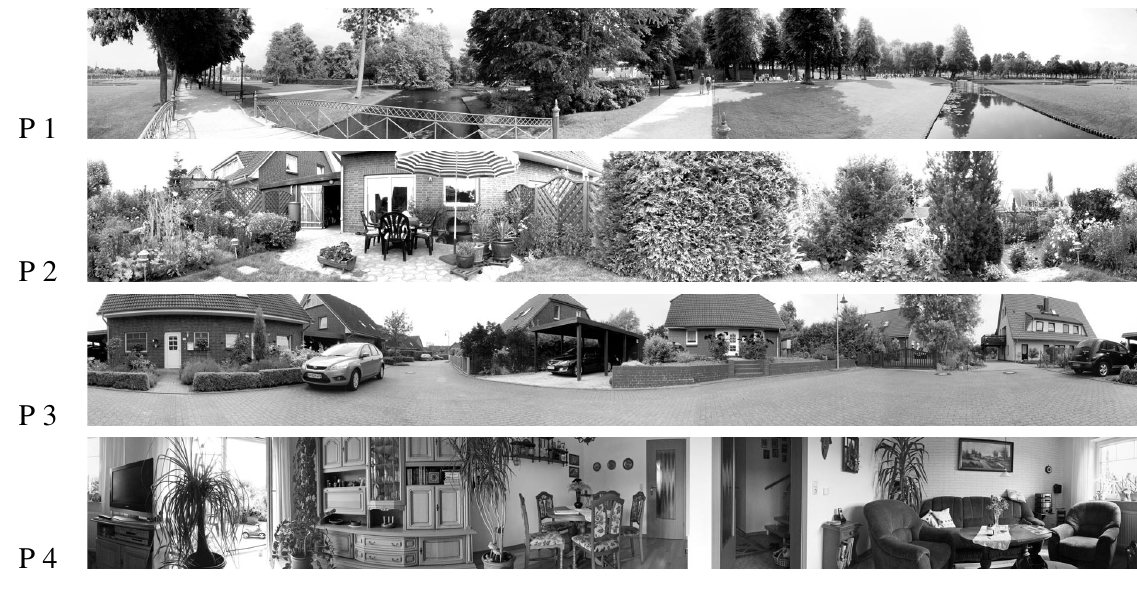
Figure 4. For the different tests four different panoramic images were used. These images where generated using photo stitching. The images have a size of 3,600 × 442 pixels, corresponding to 10 pixel / ◦ horizontal